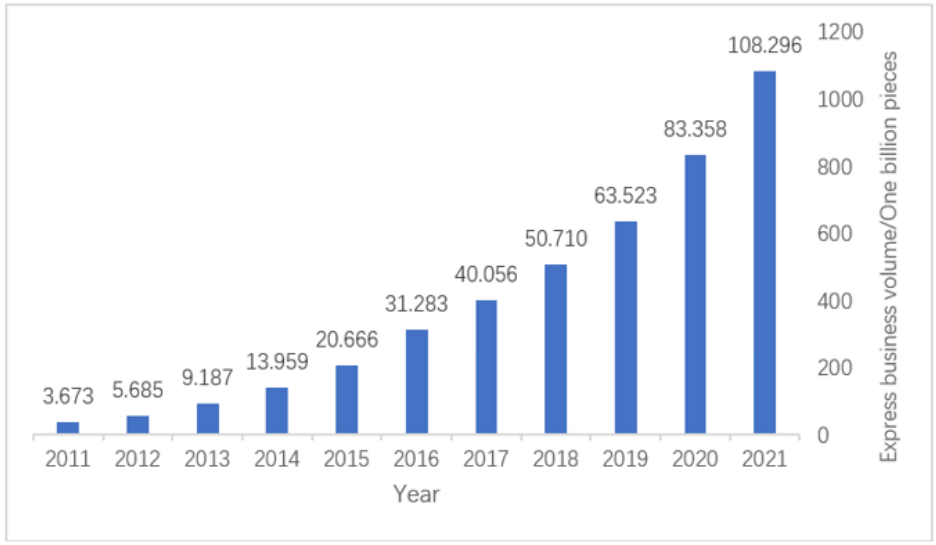
Figure 1. The 2011 – 2021 express business volume . Figure 1. The 2011–2021 express business